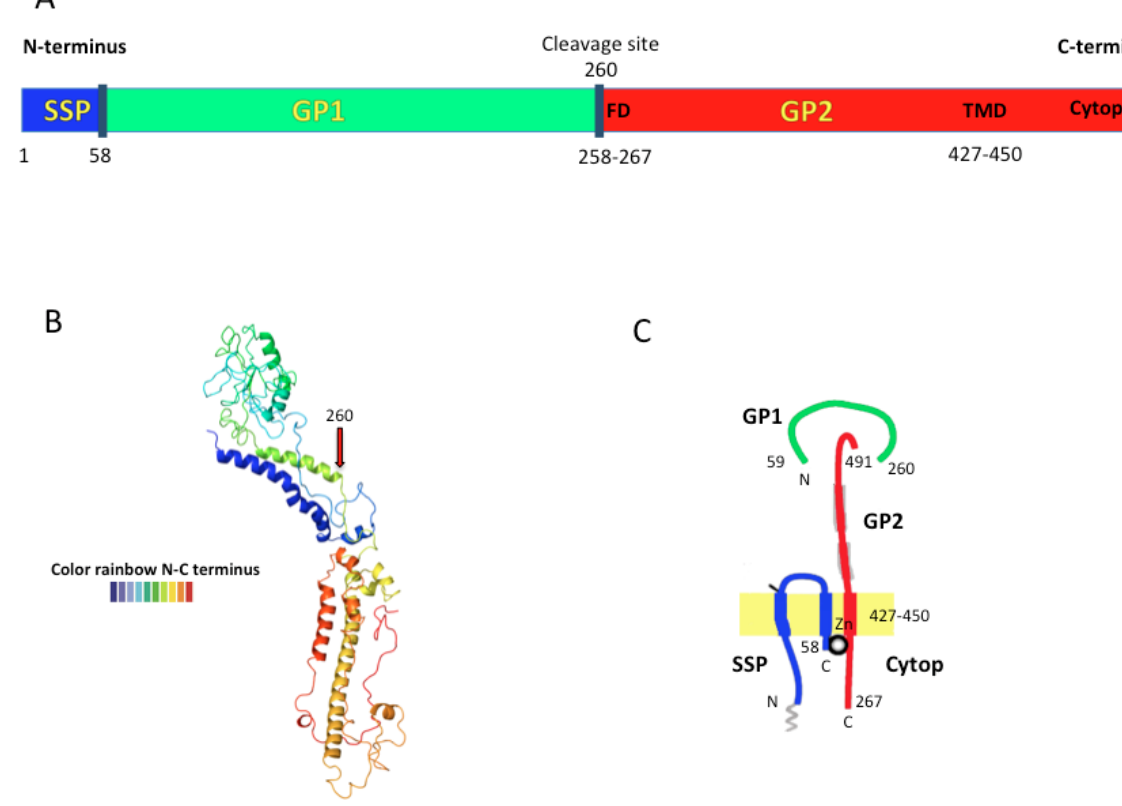
Figure 2. The LASV envelope glycoprotein precursor (GPC) structure is shown in A ) from N- to C-terminus containing SSP, GP1 and GP2 proteins. The dark blue lines represent the cleavage points. The fusion domain (FD); transmembrane domain (TMD), and cytoplasmic domain (Cytop) are shown in brown letters (modified from [19]). B ) The predicted Lassa-Josiah GPC structure obtained by open-source software (Phyre 2 ). The structure goes from N-terminus (blue) to C-terminus (red). C ) Schematic representation of the trimeric GPC subunit assembled in the cell membrane. GP1 is the most external protein bound to GP2 that is embedded in the lipid membrane. GP2 is thought to interact with SSP through an inter-subunit zinc finger (ball) (modified from